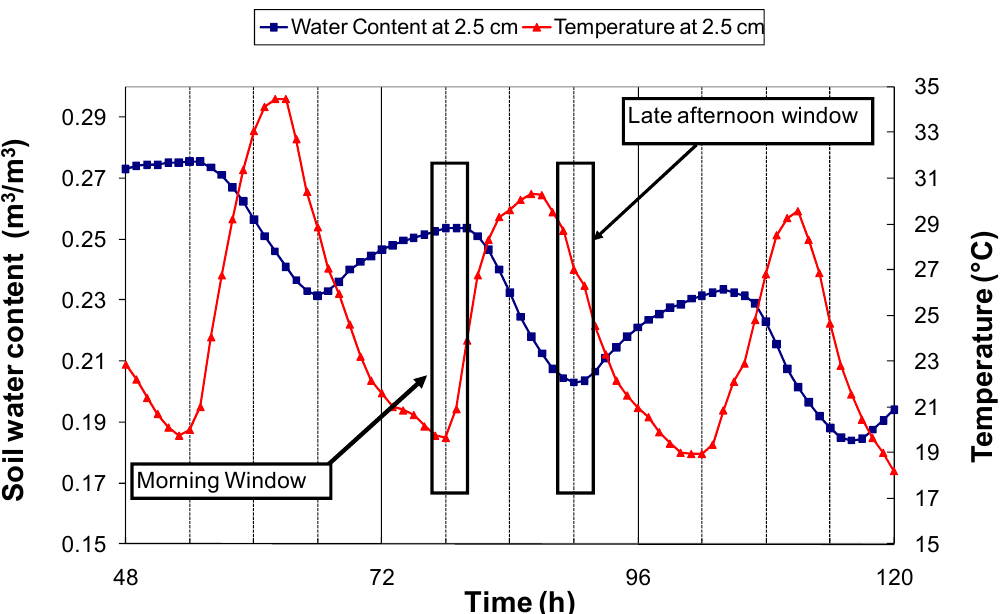
Figure 2. Concurrent simulated variations of soil water content and soil temperature during a drying cycle as calculated by the TEC model for the silt loam soil (CO-SiL). Solid grids at 48, 72 and 96 h correspond to midnight.